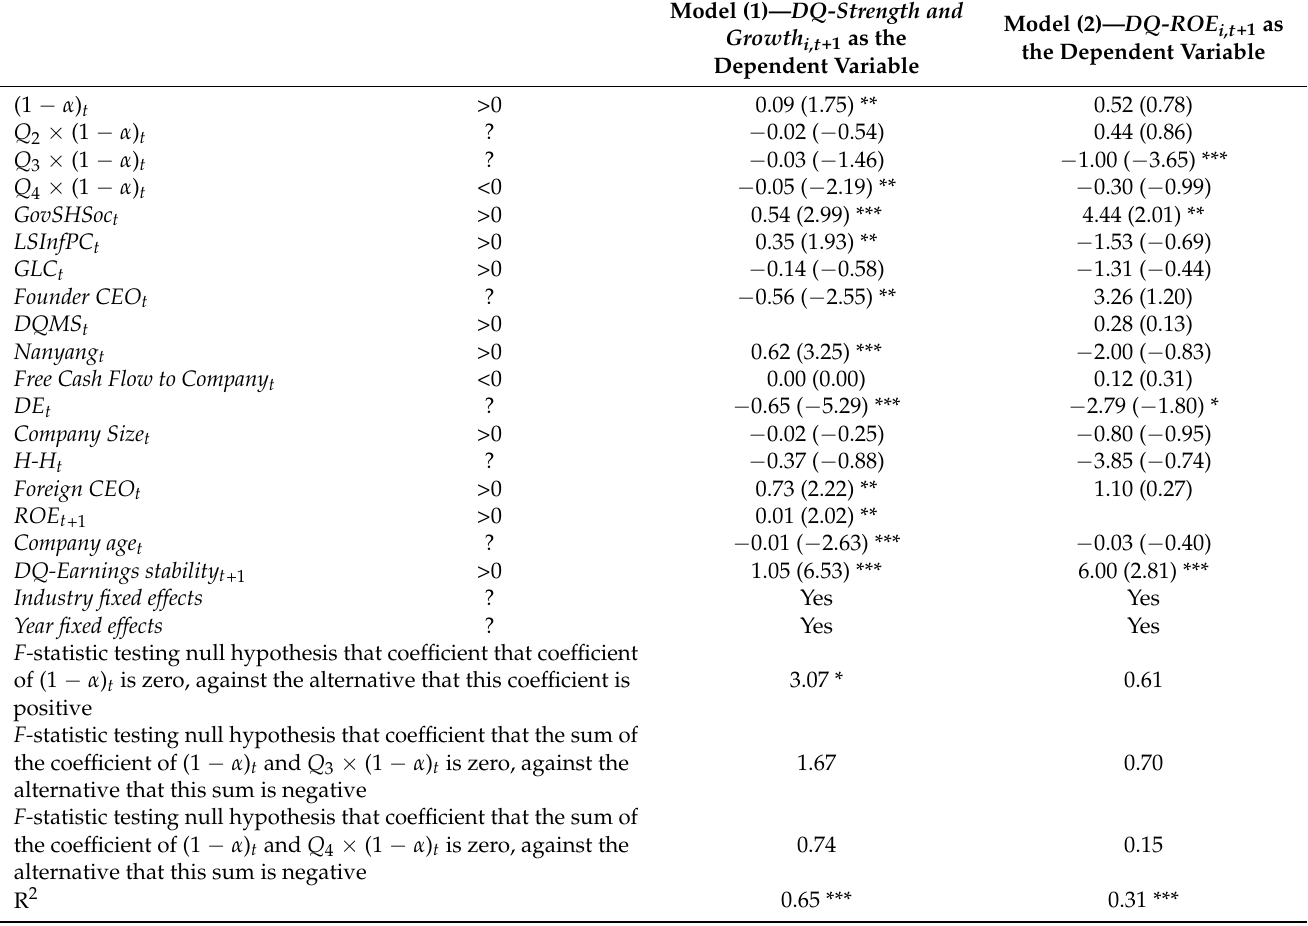
Table 5. OLS estimation of models testing H2—Using default classifications of government-related investors.